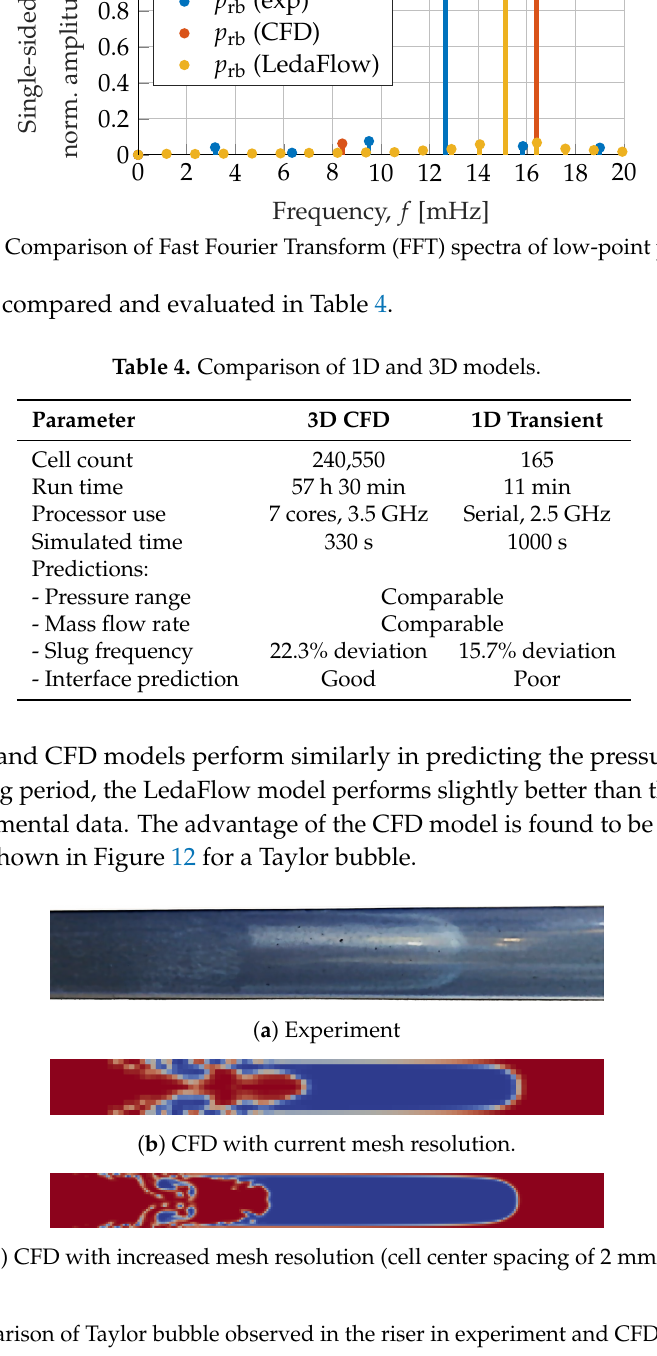
Figure 12. Comparison of Taylor bubble observed in the riser in experiment and CFD. The pictures are rotated 90 ◦